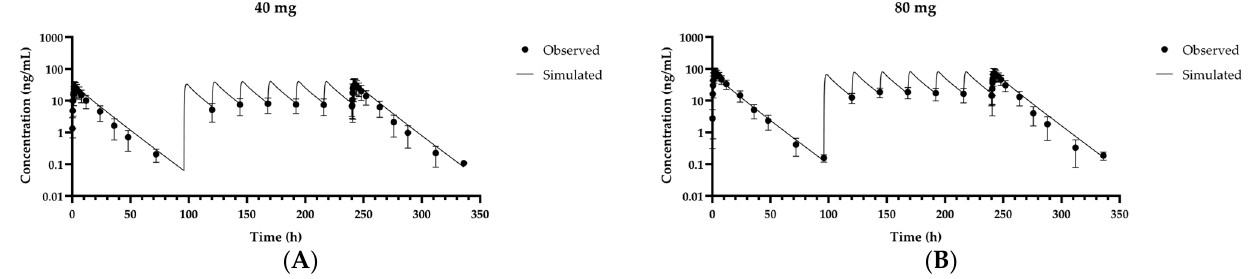
Figure 4. Observed and simulated fexuprazan time-concentration profiles at first doses of 40 mg ( A ) and 80 mg ( B ) in Korean, Caucasian, and Japanese populations. Solid lines represent results of optimized simulation or model fitting. Closed circles ( ● ) represent observed data [1,23] . Data are as means ± SD for 24 volunteers including all Korean, Caucasian, and Japanese populations.